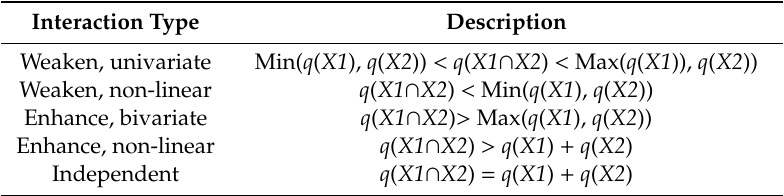
Table 4. Types of interaction relationships between two